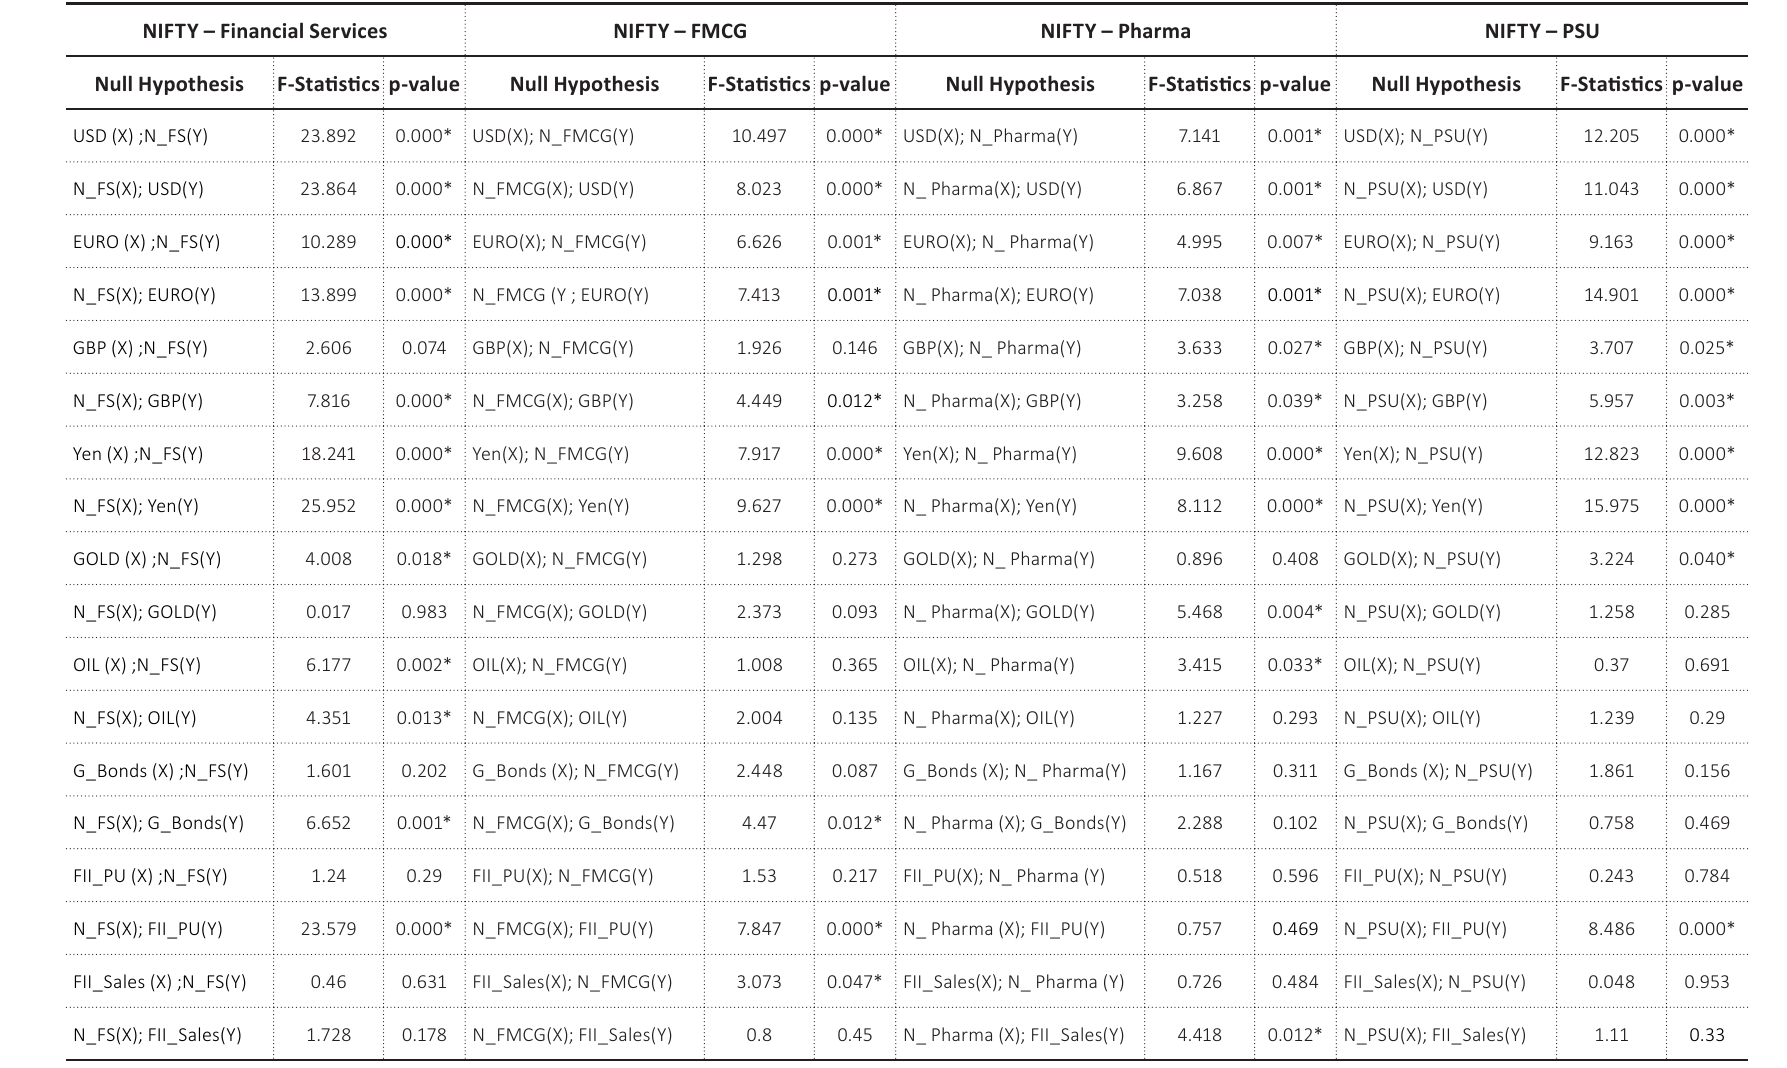
Table A3. Granger causality test results of NIFTY – Financial services, FMCG, Pharma, PSU